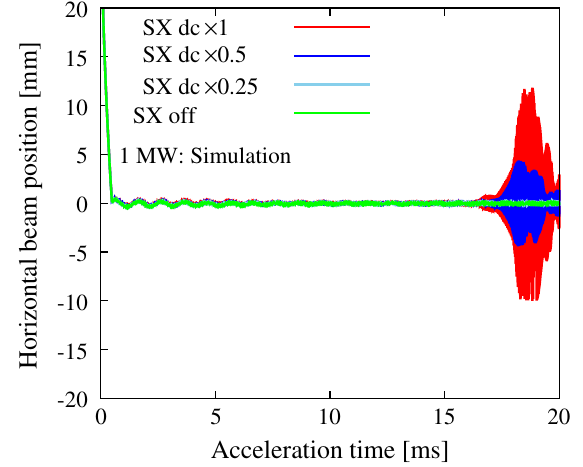
FIG. 24. Simulated results of beam instability suppression at 1 MW obtained by reducing the degree of chromaticity correc- tion. In addition to the proper manipulation of ν x (see Fig. 19), no more than a quarter of the full ξ correction at injection and almost no correction at extraction can be applied to stabilize the designed beam power of 1 MW. energy only (green solid and dashed lines in Fig. 10 for the SX field and ξ x , respectively). The plots in other colors correspond to a reduction of the degree of ξ correction to half and quarter at injection by further scaling down the SX dc × 1 field to SX dc × 0 . 5 (blue) and SX dc × 0 . 25 (sky blue). The green curve shows a case where no ξ correction was applied (blue dotted line in Fig. 10) by turning off SX for the entire cycle. The beam is unstable even when the degree of ξ correction is reduced by half at injection.